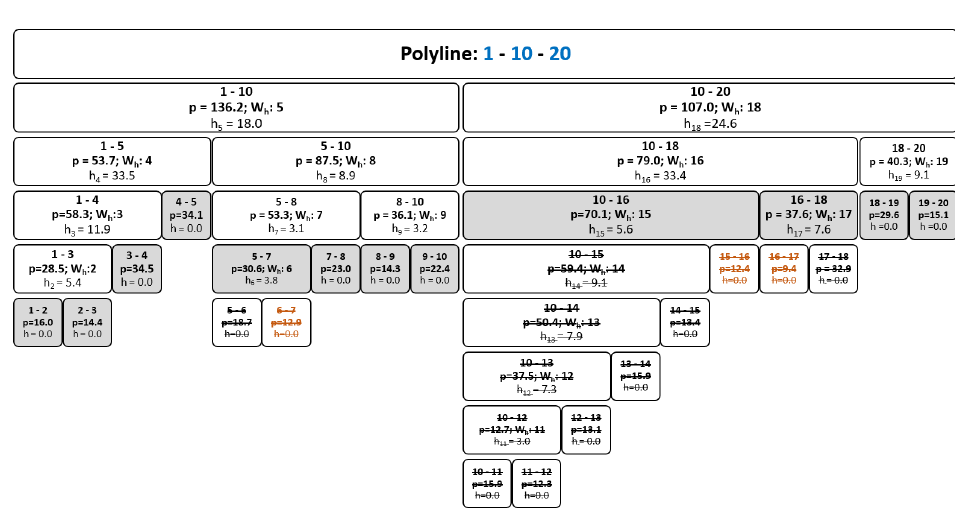
Fig. 4. Structure of the binary tree of ordered polyline L u after simplification from scale 1:10,000 to scale 1:20,000 (in brown − triangles that do not meet the fr d condition; crossed out − triangles rejected as a result of simplification; shaded blocks − the polyline remaining after simplification)